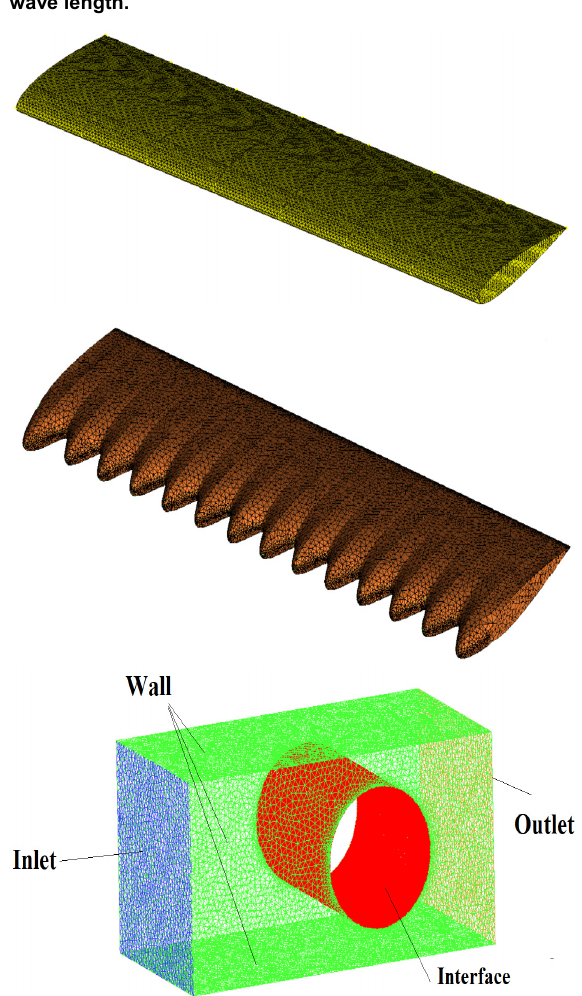
Figure 5. Two different blade geometries based on the NACA0015 aerofoil blade (up) and the test section